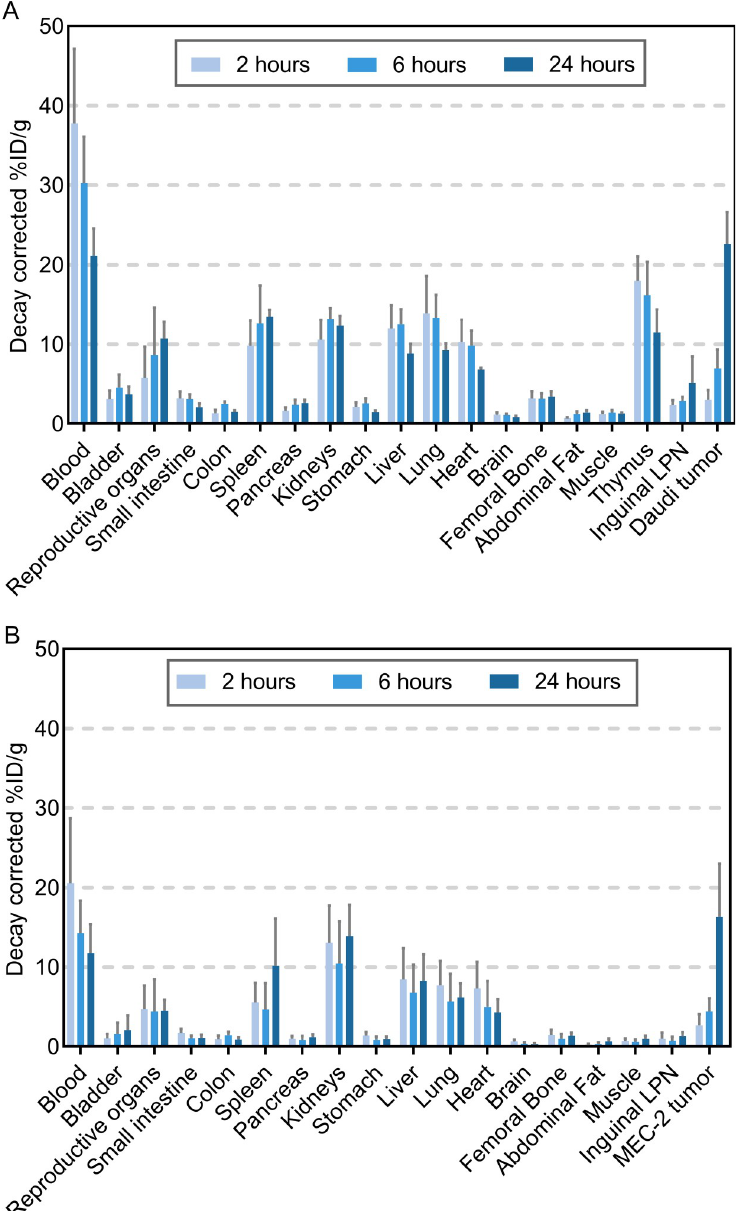
Fig 2. Biodistribution of 212 Pb-NNV003. %ID/g of 212 Pb-NNV003 in tissues of (A) CB17 SCID mice with Daudi s.c. xenografts (n = 5 per time point) and (B) R2G2 mice with MEC-2 s.c. xenografts (n = 4 at 6 h, n = 10 at 2 and 24 h). Data presented as averages with error bars = SD, LPN = Lymph